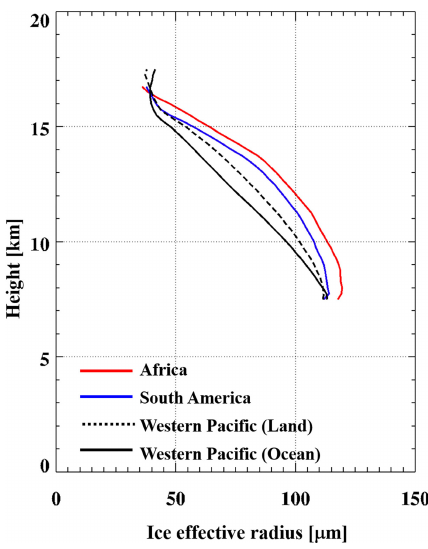
Figure 9. Same as Fig. 4 but for ice effective